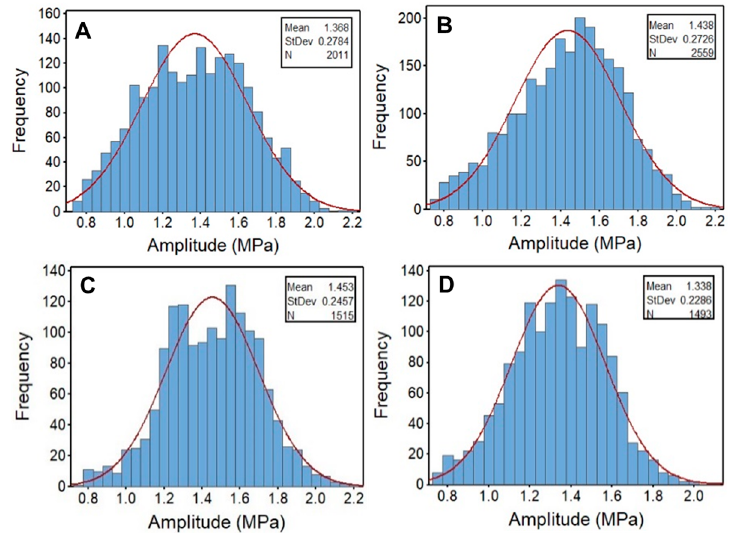
Figure 19. Transformed histogram of the obtained amplitude of the PLC signal: ( A ) Al–0.5wt. %Mg–10wt. % A206 samples, ( B ) Al–0.5wt. %Mg–10wt. % A206/1 wt. % γ Al 2 O 3 samples, ( C ) Al–0.5wt. %Mg–20wt. % A206 samples, and ( D ) Al–0.5wt. %Mg–20wt. % A206/1 wt. % γ Al 2 O 3 samples.